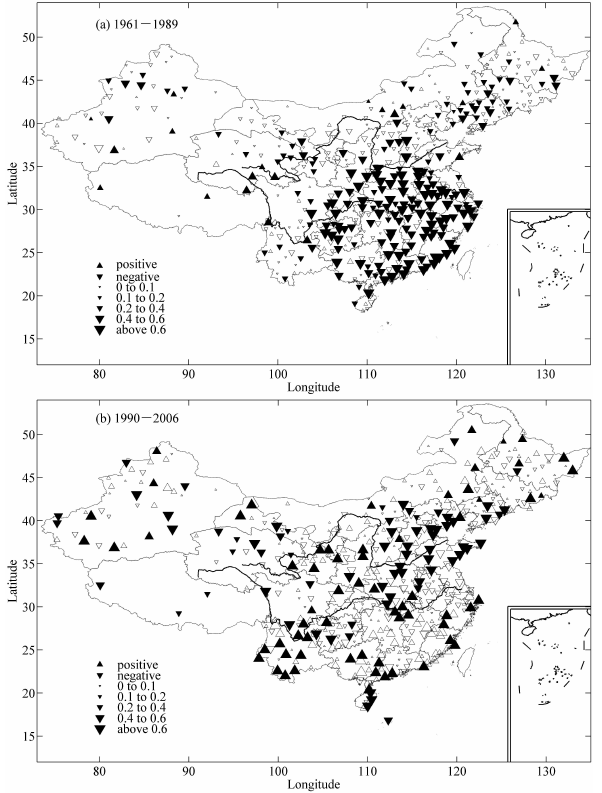
Fig. 5. Spatial distribution of the trend slopes of annual mean solar irradiance estimated by the hybrid model at CMA stations: (a) from 1961 to 1989, and (b) from 1990 to 2006. The derived trends for 1990 ∼ 2006 may have larger uncertainties due to the small size of samples. The solid triangle symbol means a trend that passes the significance test ( p < 0 .